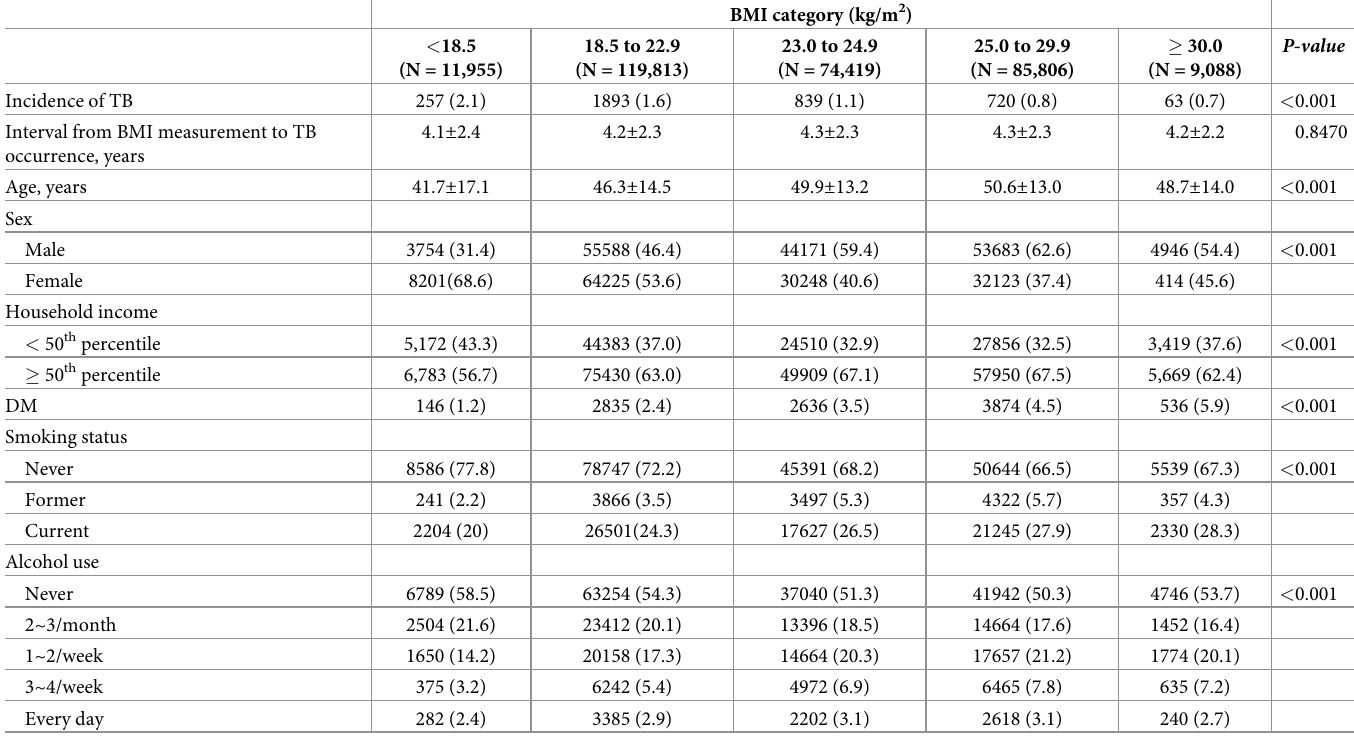
Table 1. Baseline characteristics of the